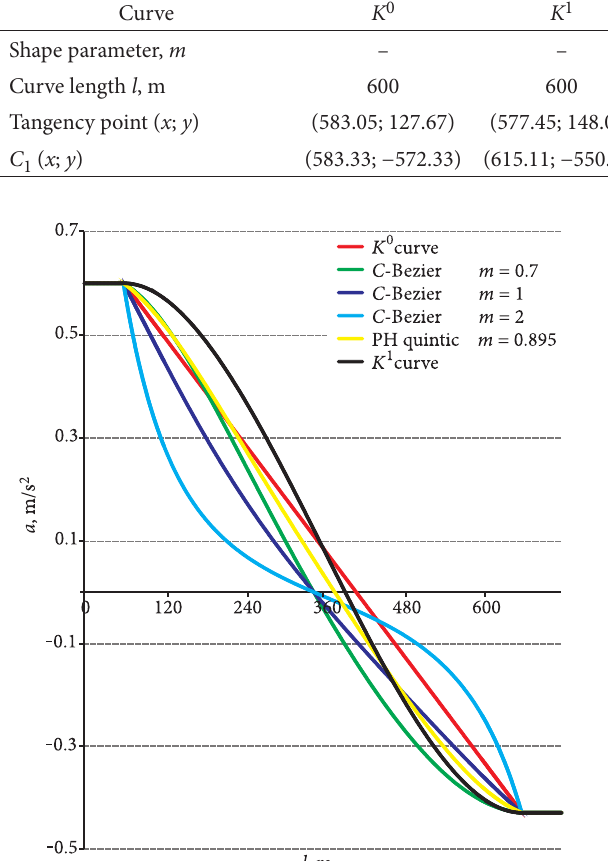
Fig. 11. Lateral unbalanced acceleration along the S -shaped curves